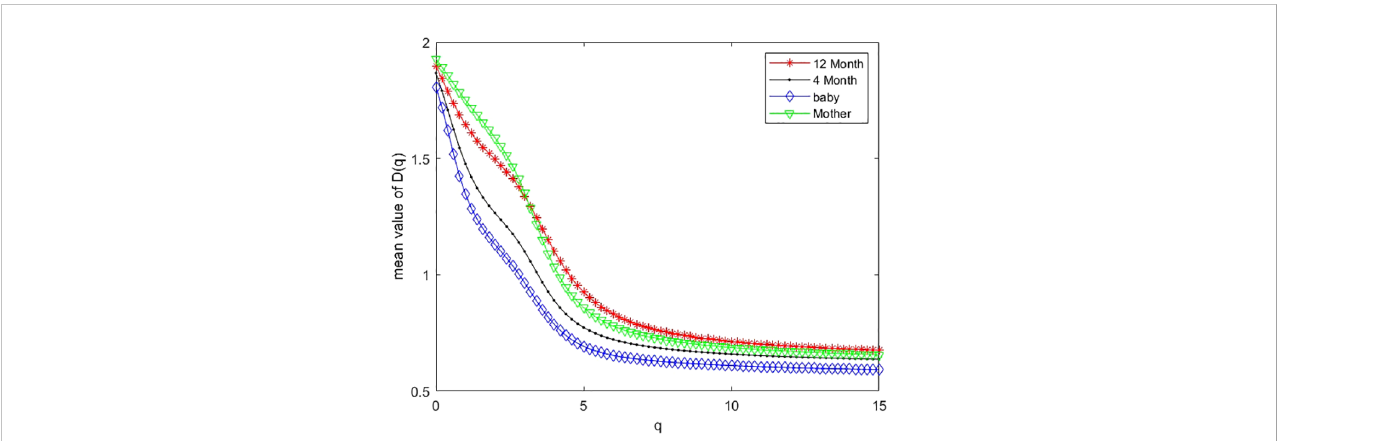
FIGURE 9 Mean values of multifractal dimension of 100 infants ’ gut microbiomes when they are 12 months old (12 M), 4 months old (4 M), and a newborn baby (baby), and that of their mother